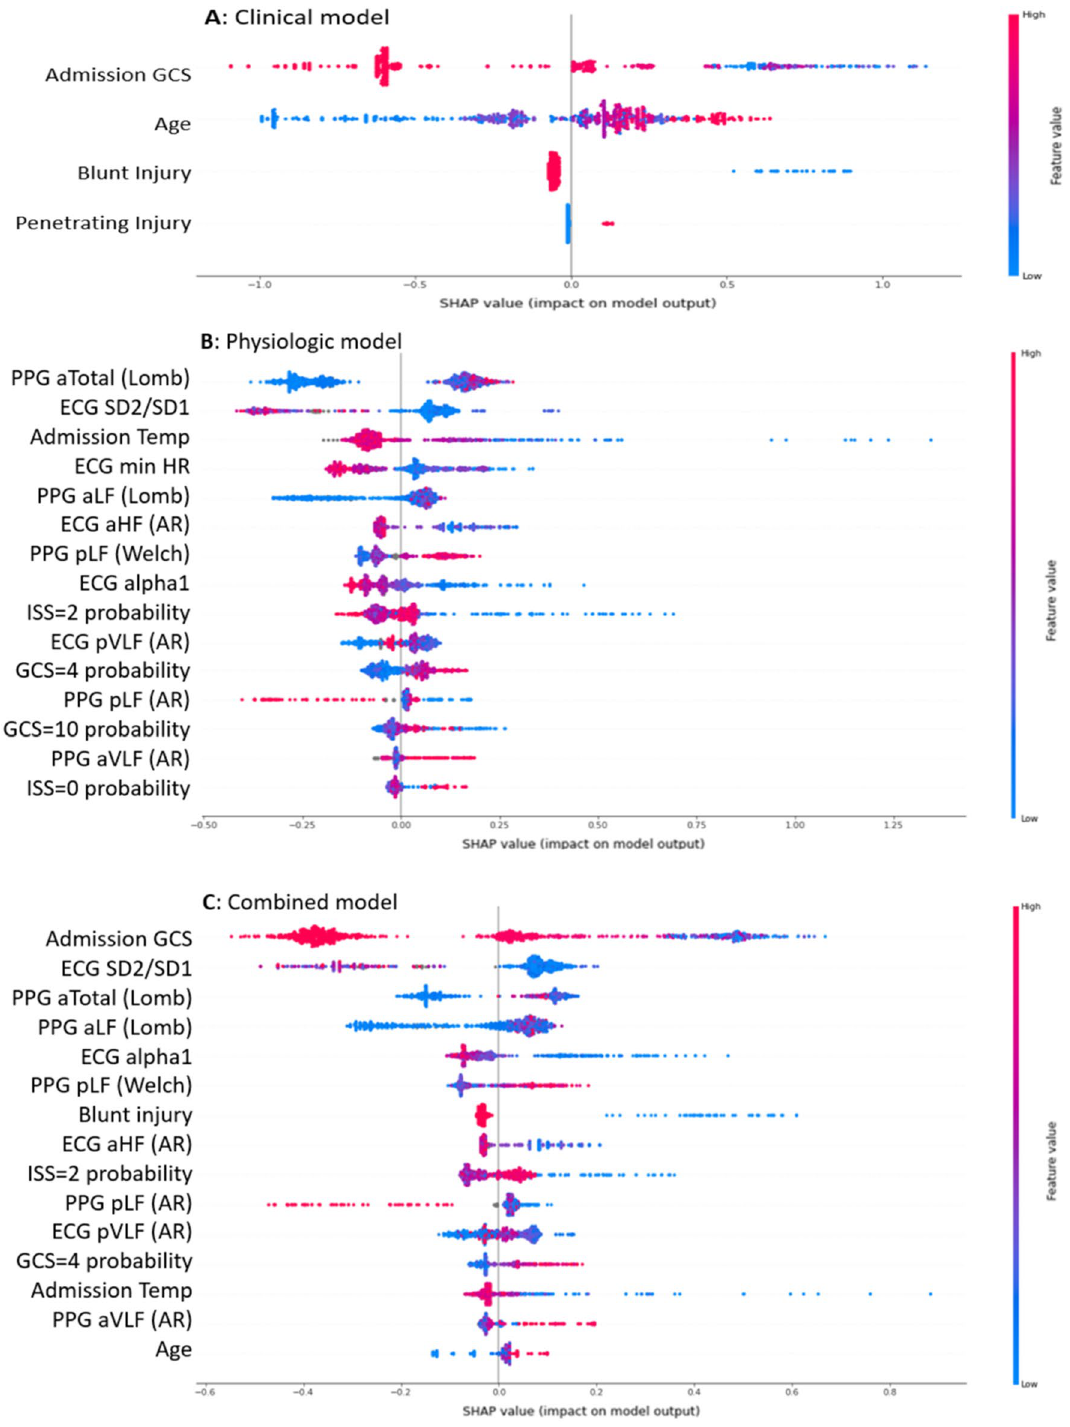
Figure 5. For the clinical ( A ), physiologic ( B ), and combined ( C ) neurologic decline (ND) prediction models, each contributing feature is displayed on the y axis. The x axis shows each feature’s Shapley Additive Explanations (SHAP) values. A larger SHAP value denotes a higher log odds ratio that a variable’s value added to the prediction. Values are represented in color ranging from red to blue (high to low). The y axis from top to bottom ranks the variables’ importance, which is the mean of their absolute SHAP